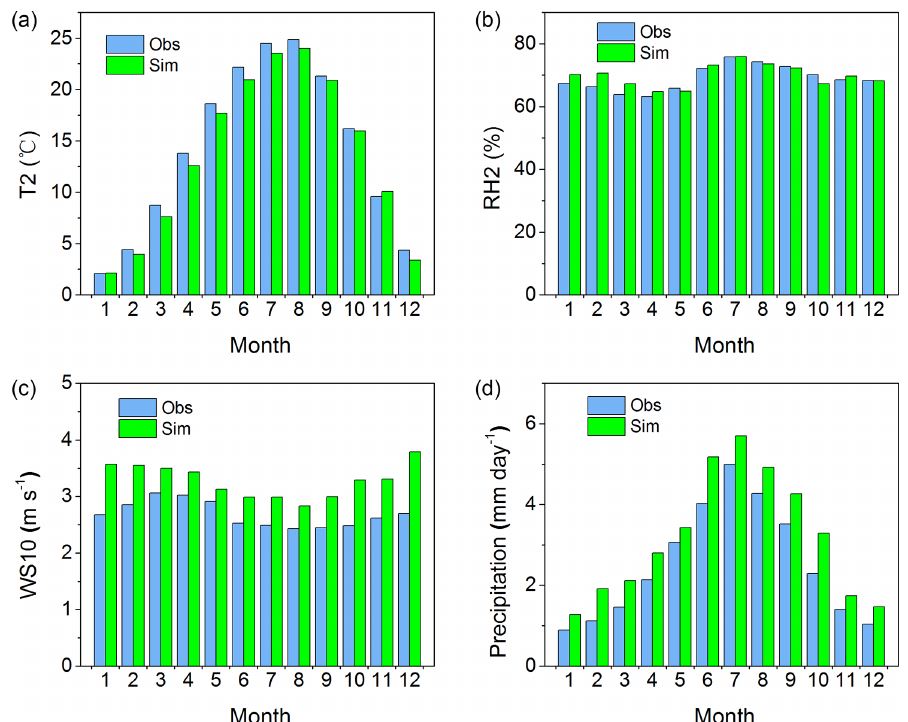
Figure 4. The 5-year averaged monthly observations (blue) vs. simulations (green) for (a) 2m temperature (T2), (b) 2m relative humidity (RH2), (c) 10m wind speed (WS10), and (d) precipitation under the climatological application during